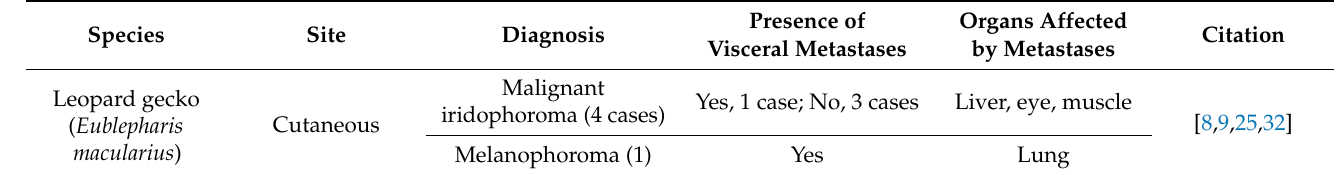
Table 3. Clinical features of chromatophoromas in the reptile family: Eublepharidae .